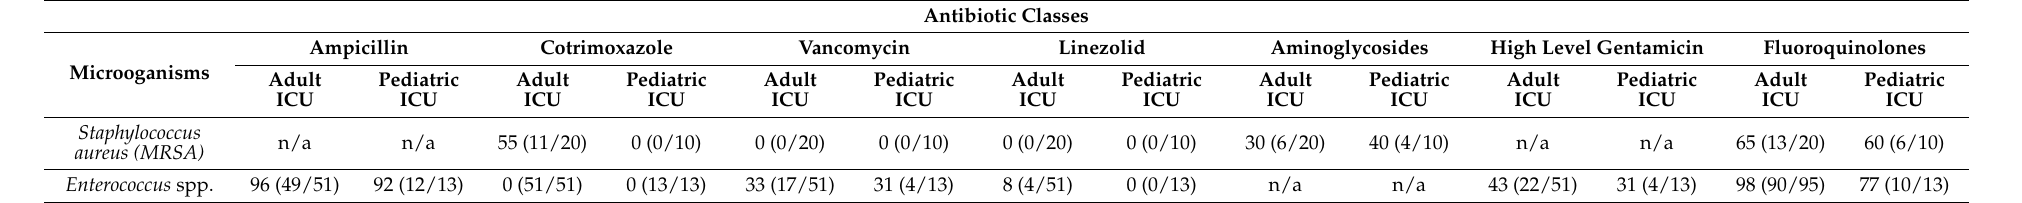
Table 4. Percentage (%) of antibiotic resistance among different Gram-positive bacterial isolates obtained from both adult and pediatric